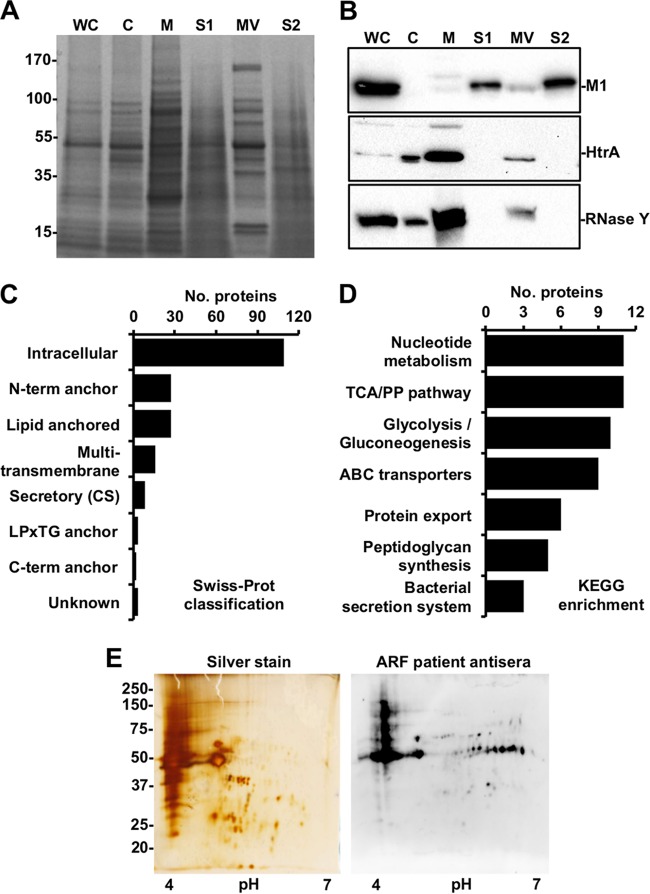
GAS MVs carry classically secreted and anchorless virulence proteins. (A) Protein profiles of ISS3348 whole-cell extract (WC), cytoplasm (C), membrane (M), secreted fraction prior to ultracentrifugation (S1), MV, and secreted fraction after centrifugation (S2). (B) Western blot of virulence-associated proteins identified in MVs. The samples in each lane are the same as in panel A. (C) Swiss-Prot classification of nano-LC-MS/MS-identified MV proteins. (D) KEGG categories enriched in MV proteins. (E) Silver-stained 2D protein profile and respective 2D Western blot of ISS3348 MV proteins probed with ARF patient antisera and anti-human IgG-Fc-horseradish peroxidase (HRP).